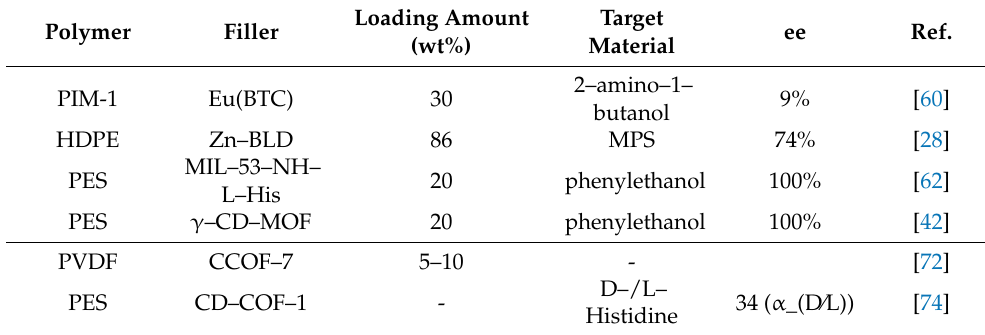
Table 1. MOF- or COF-based mixed matrix membranes.